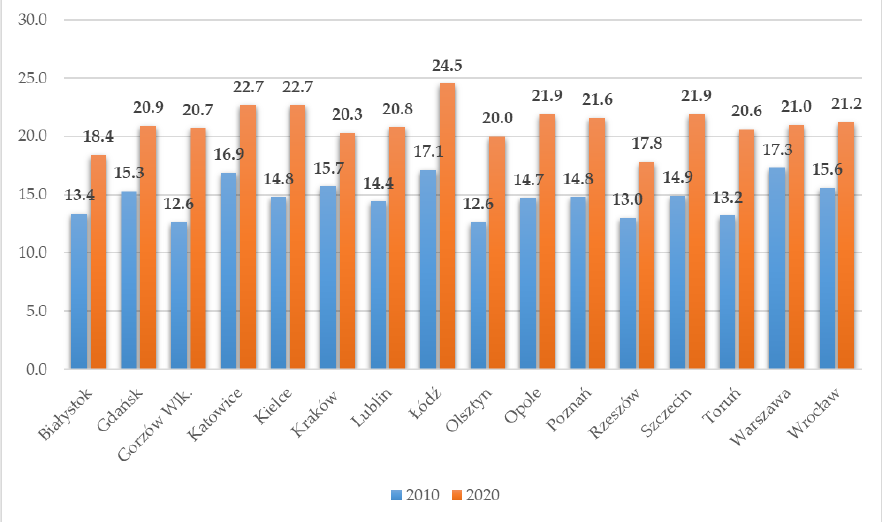
Figure 4. Percentage of people aged 65 and older in the total population in the surveyed Polish cities in 2010 and 2020.